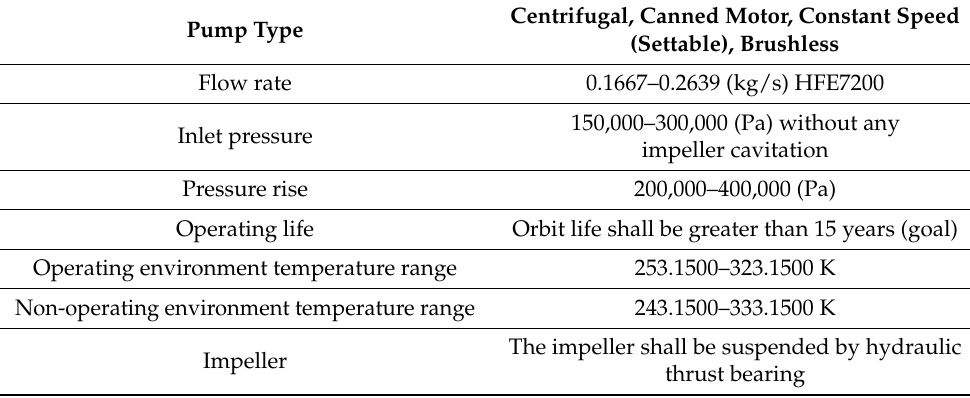
Table 1. Pump technical specifications.